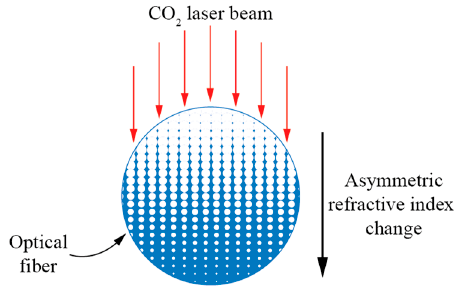
Figure 10. Schematic diagram of asymmetric index profile within a cross-section of a CO 2 -laser- induced LPFG.